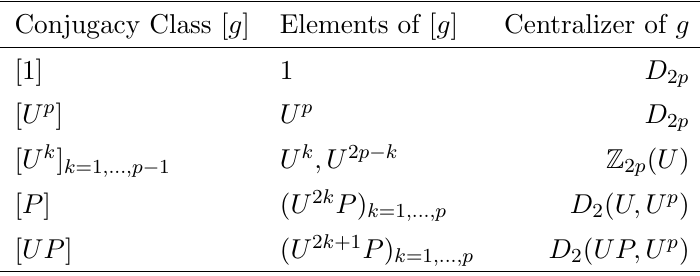
Table 2 . Conjugate orbits and stabilizers of D n for n